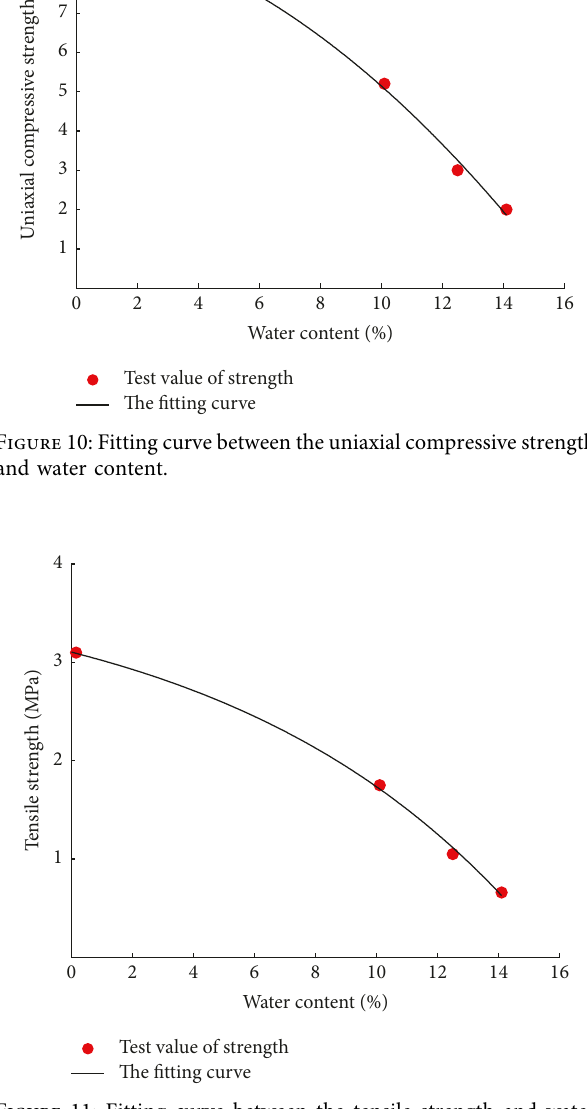
Figure 11: Fitting curve between the tensile strength and water